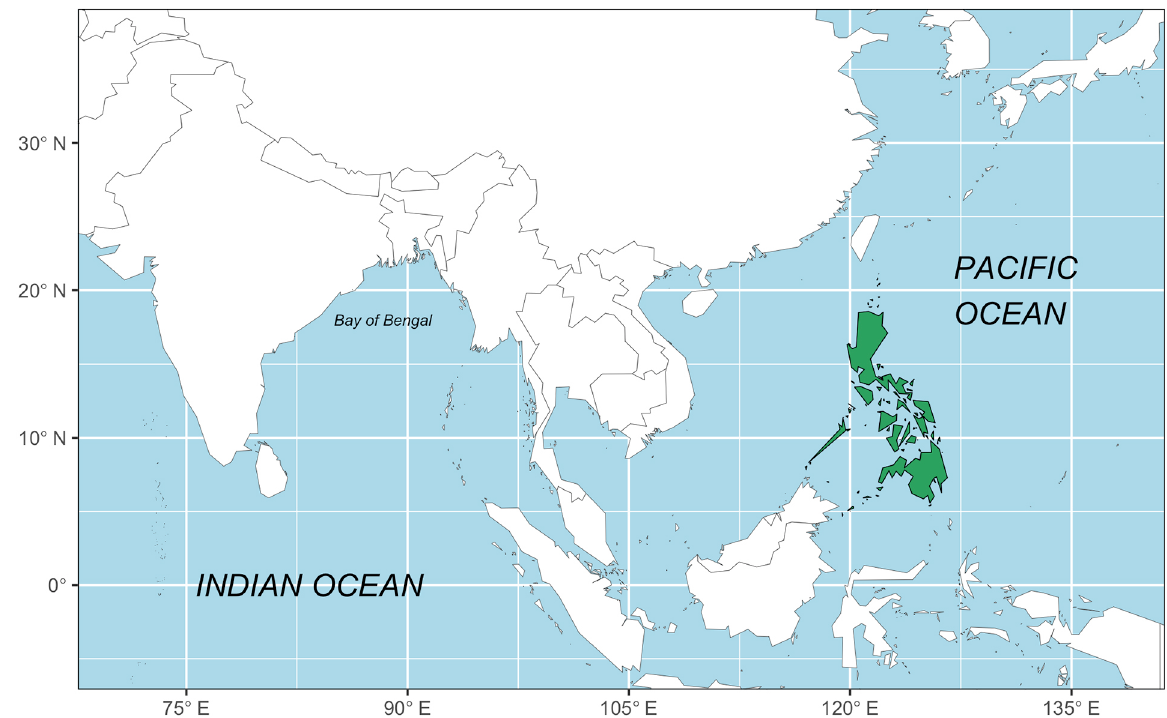
Fig.1. Location map of the Philippines (Data source: R maptool